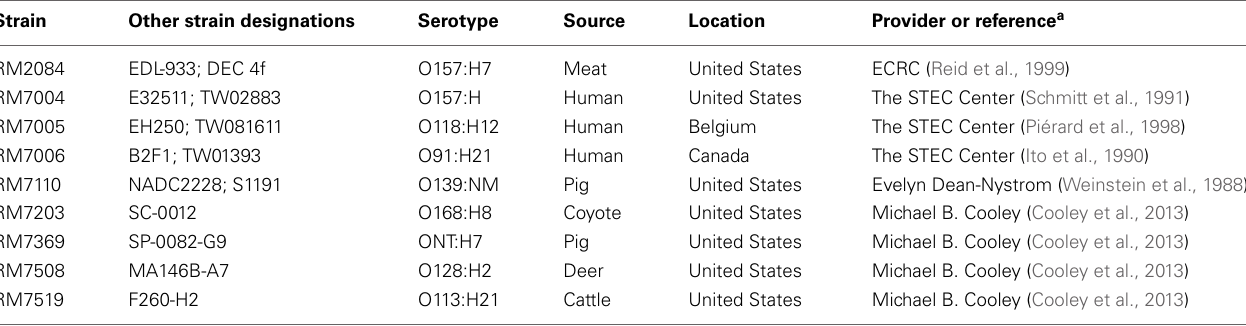
Table 2 | Shiga toxin-producing Escherichia coli reference strains used in this study.